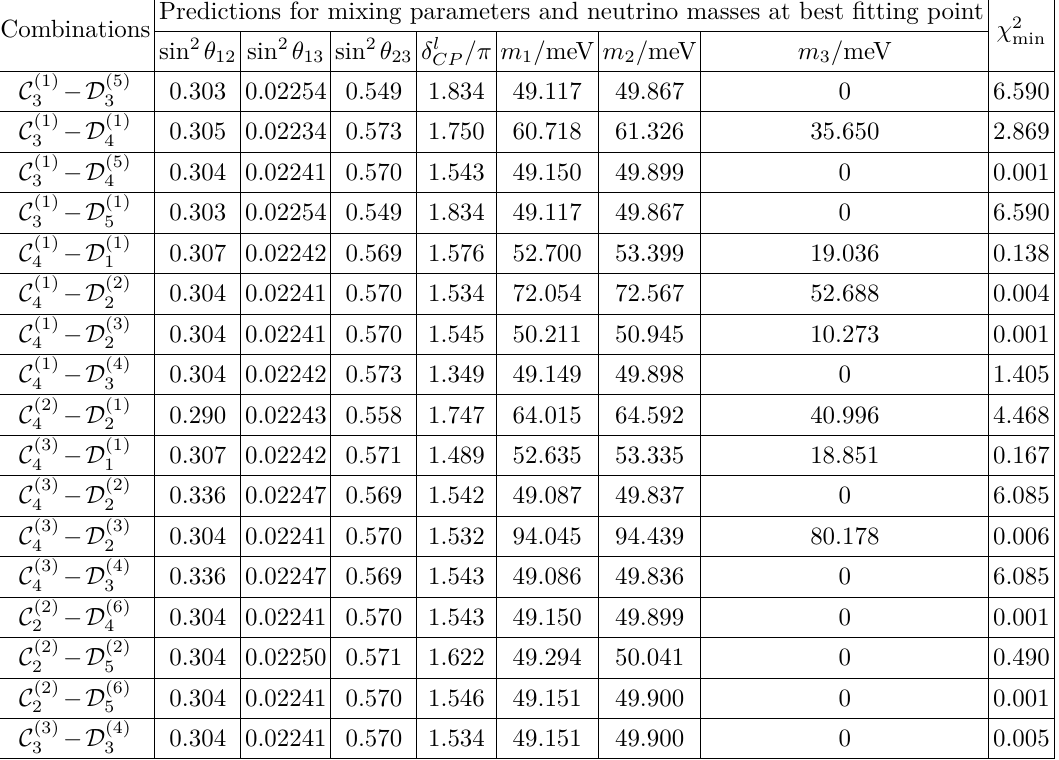
Table 17. The same as in table 15 but for IO neutrino mass spectrum and for the representative models of table